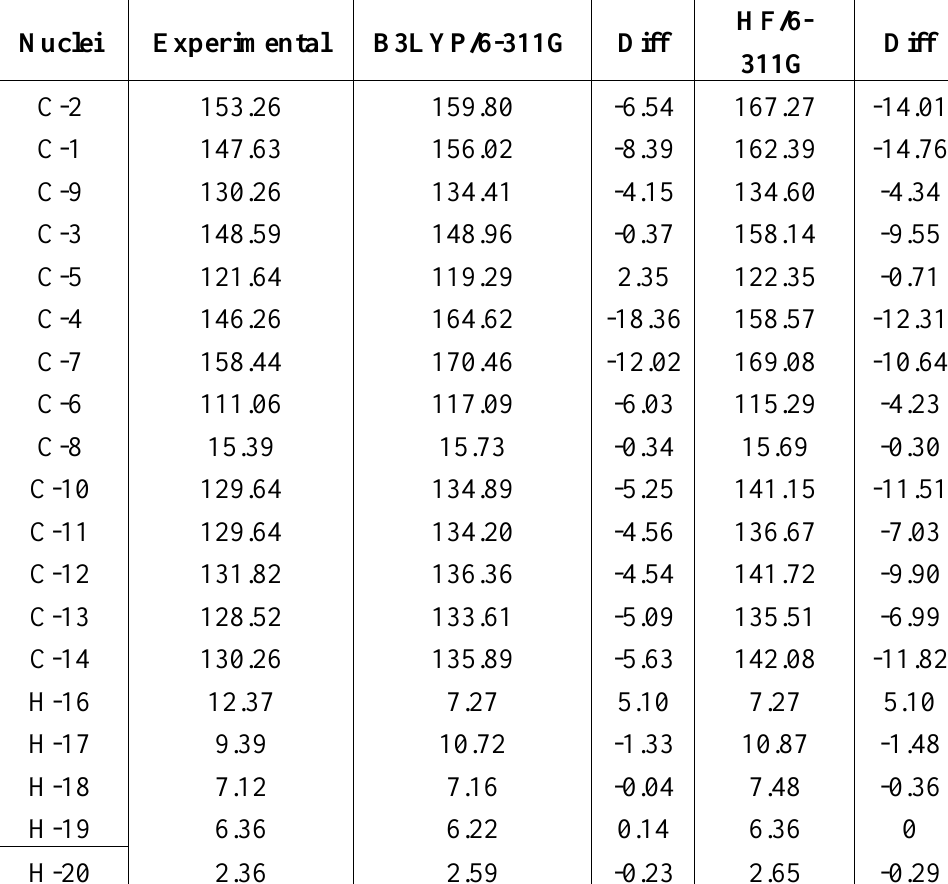
Table 4. Comparison between experimental and calculated chemical shifts (ppm) of 2d